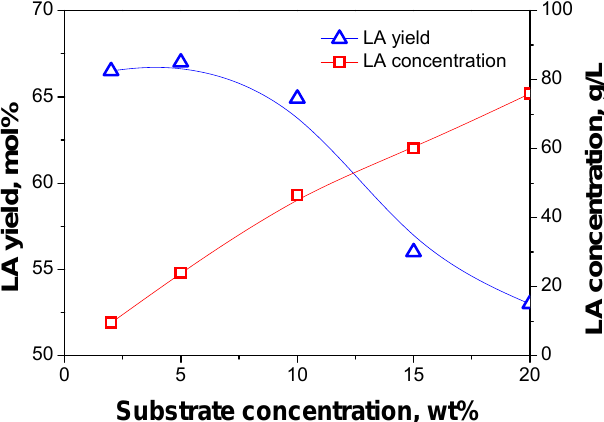
Figure 10. Effect of substrate concentration on concentration and yield of